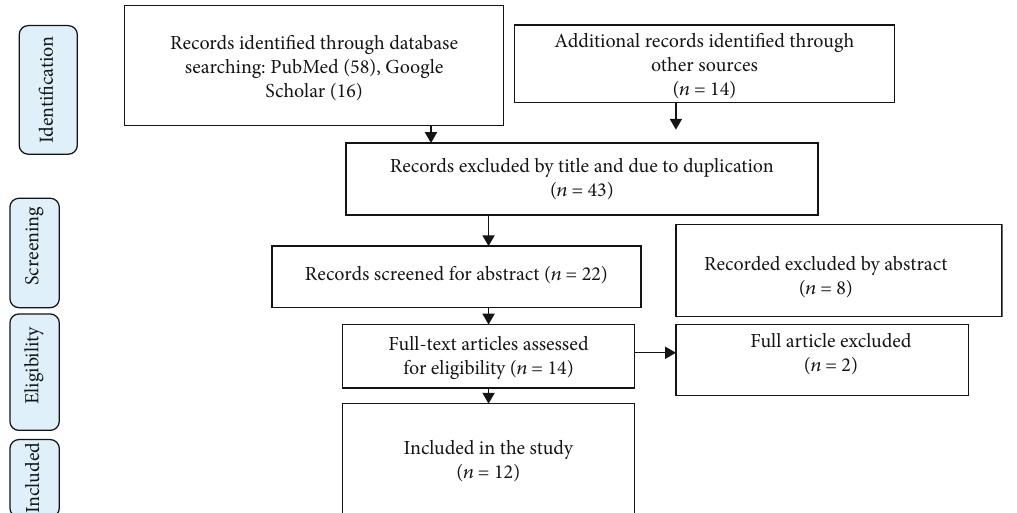
Figure 1: PRISMA fl ow diagram for showing screening and selection process of duties.